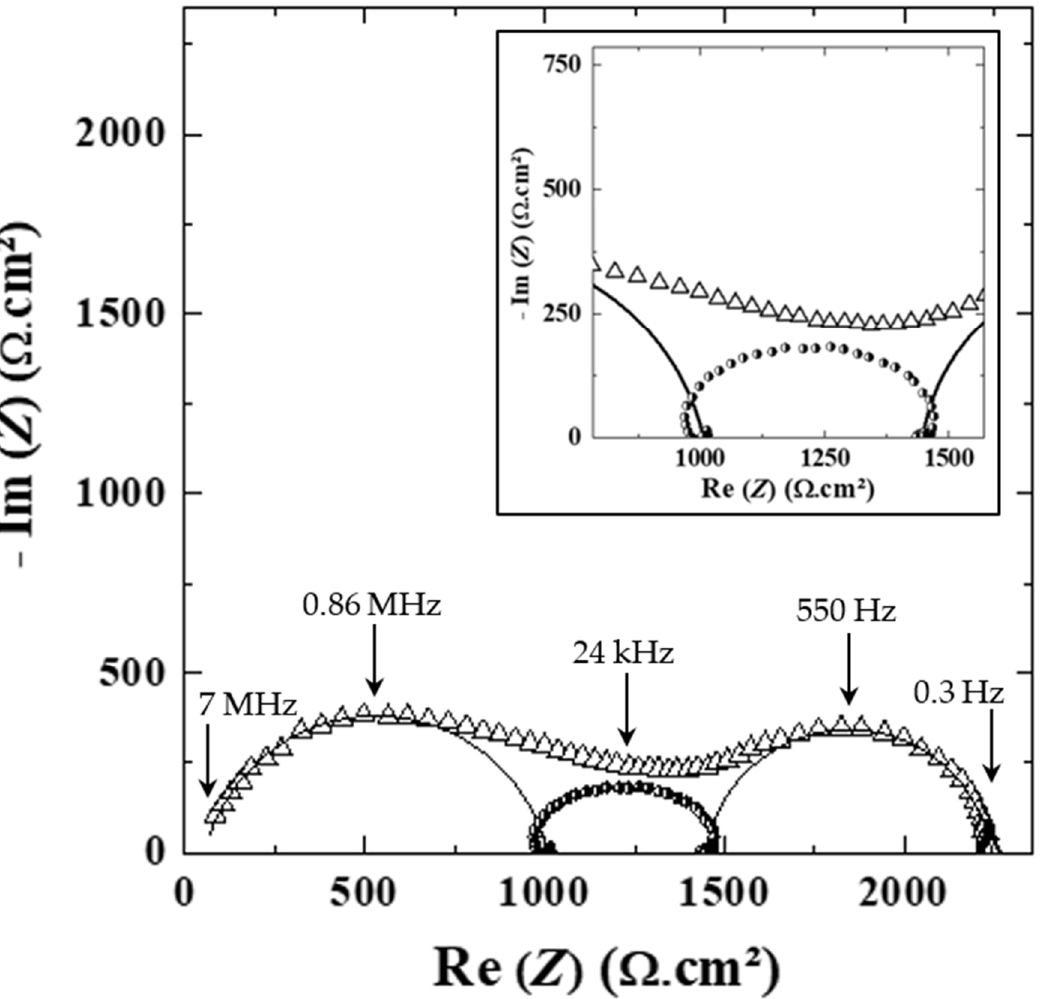
Figure 7. Impedance spectrum of the ( △ ) HySI_25 electrolyte at 60 C in Li symmetric cell. The fit of the contribution arising from the rich PEO phase (0.86 MHz) and the Li/electrolyte interface (550 Hz) are shown as a straight and dotted line, respectively. The contribution at MF (24 kHz, black circle) is obtained by the subtraction method (see text, TFSI/SiO 1.5 phase contribution). The inset is a magnification in the MF range.